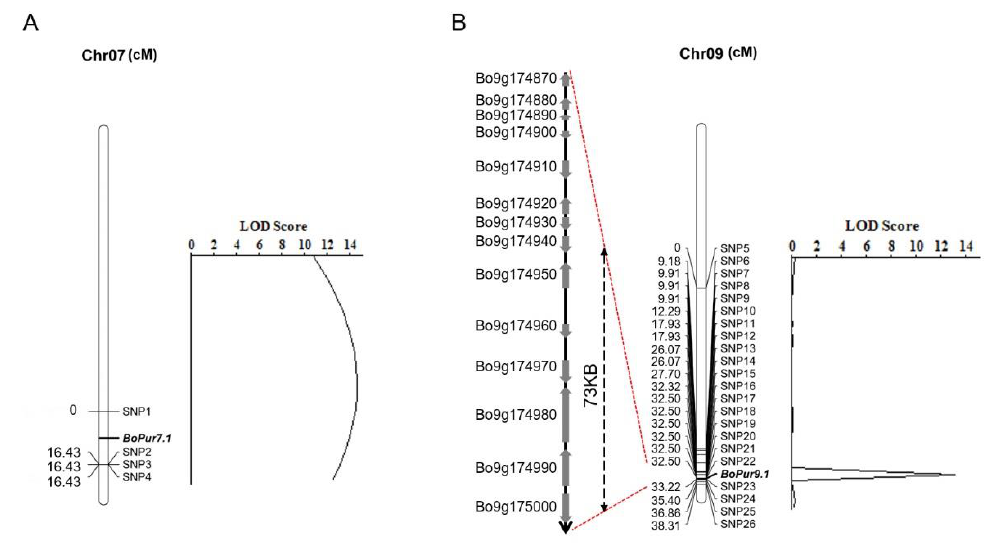
Figure 3. Maps of the Pur loci on C07 ( A ) and C09 ( B ) constructed using 26 SNP markers. Table 2. Quantitative trait loci ( P < 0.05) associated with anthocyanin biosynthesis in broccoli. Chromosome